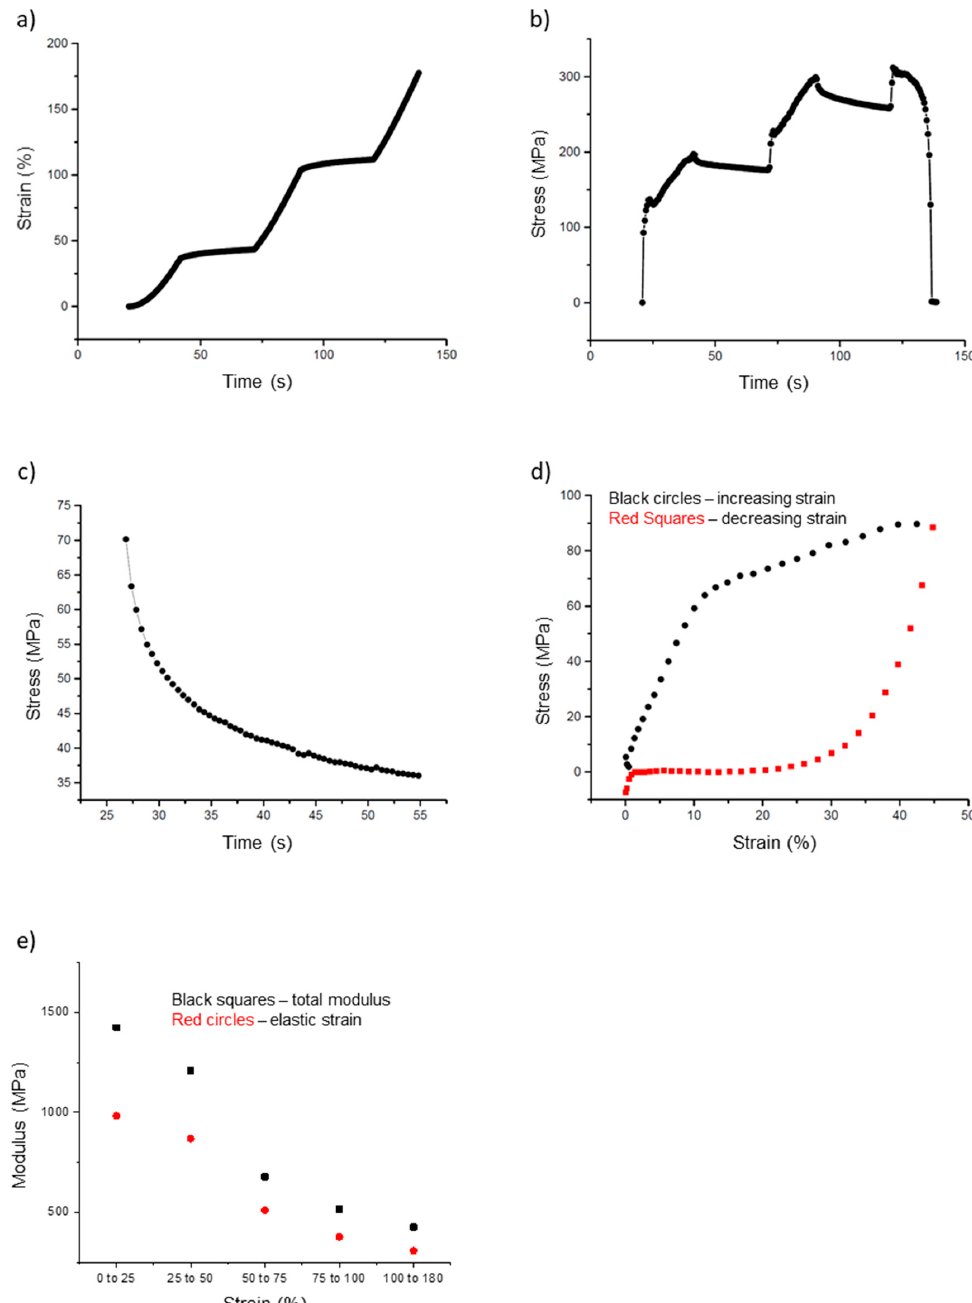
Figure 7. Incremental stress–strain curves and cyclical stress–strain curves of electrospun 50:50 fibrinogen:PCL fibers. ( a ) Strain versus time curve showing sequential periods of increasing strain (20 s) followed by constant strain (30 s). ( b ) Fiber stress versus time, fiber stress increases as the fiber is pulled; it decays during each constant strain period of the incremental stress-strain tests. ( c ) Close up of Figure 7b, showing a single stress relaxation curve of an incremental stress-strain test. Plotting stress versus time permits curve-fitting to Equation (15) to extract the total and elastic modulus and stress relaxation times, see main text. There is a steep initial decrease with a fast relaxation time, τ 1 , followed by a slower relaxation with relaxation time, τ 2 . ( d ) Cyclic stress–strain curve to determine energy loss and elastic limit. This graph represents one complete outward pull (black circles) and return (red squares); it highlights the large energy loss (inscribed area) experienced by the fibers. ( e ) Plot of the total and elastic moduli grouped by strain, as extracted from the incremental stress–strain curves. The data points represent averages for the strain intervals expressed on the